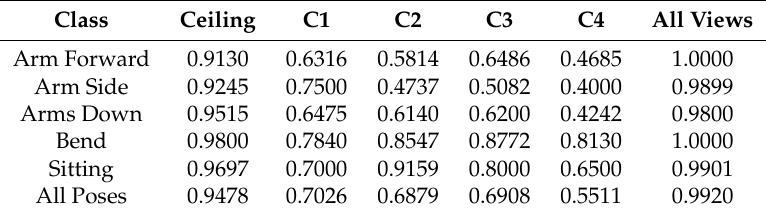
Table 6. The F1-score results from the five TISs test where C =